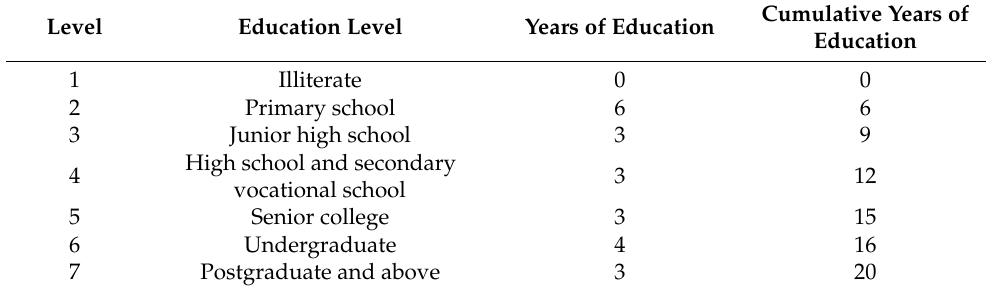
Table 1. Cumulative years of education.